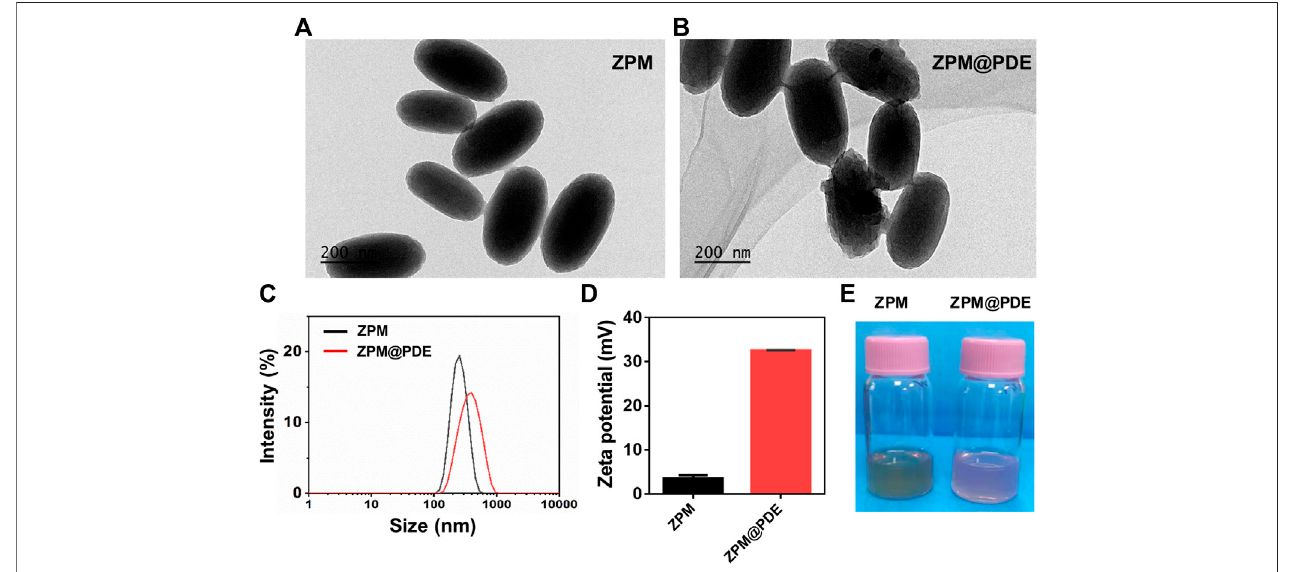
FIGURE 1 | (A,B) TEM of TZM and TZM@PDE, (C) Hydrodynamic size distribution, (D) Zeta potential, and (E) Photographs of TZM and TZM@PDE in aqueous